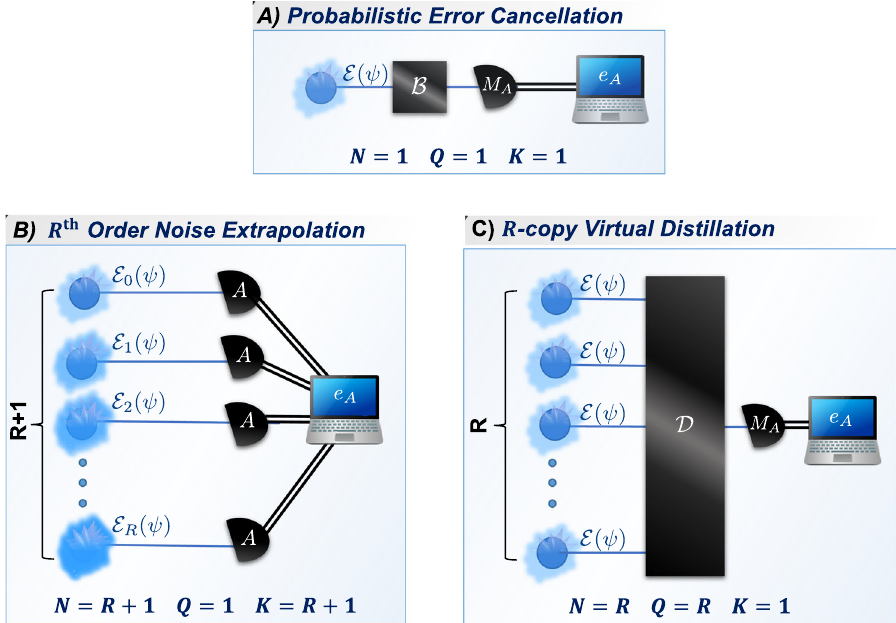
Fig. 3 Error-mitigation protocols. Our framework encompasses all commonly used error-mitigation protocols, a sample of which we outline here. A Probabilistic error cancellation 3 assumes we can only act a single coherent state each round, where it seeks to undo a given noise map E by applying a suitable stochastic operation B . Thus it corresponds to the case of Q = K = 1. B R th order noise extrapolation assumes 3,4 the capacity to synthesize R + 1 NISQ devices whose outputs represent distortions of ψ at various noise strengths. It then uses individual measurements of an observable A on these distorted states to estimate the observable expectation value on the zero-noise limit. Thus it is an example where Q = 1 and K = R + 1. C Meanwhile, R -copy virtual distillation 14,15 involves running an available NISQ device R times to synthesize R copies of a distorted state Eð ψ Þ . Coherent interaction D over these copies followed by a suitable measurement M A then enables improved estimation of 〈 A 〉 . Thus it is an example where K = 1 and Q = R . In the main text and Methods, we provide a detailed account of each protocol and how it fi ts within our